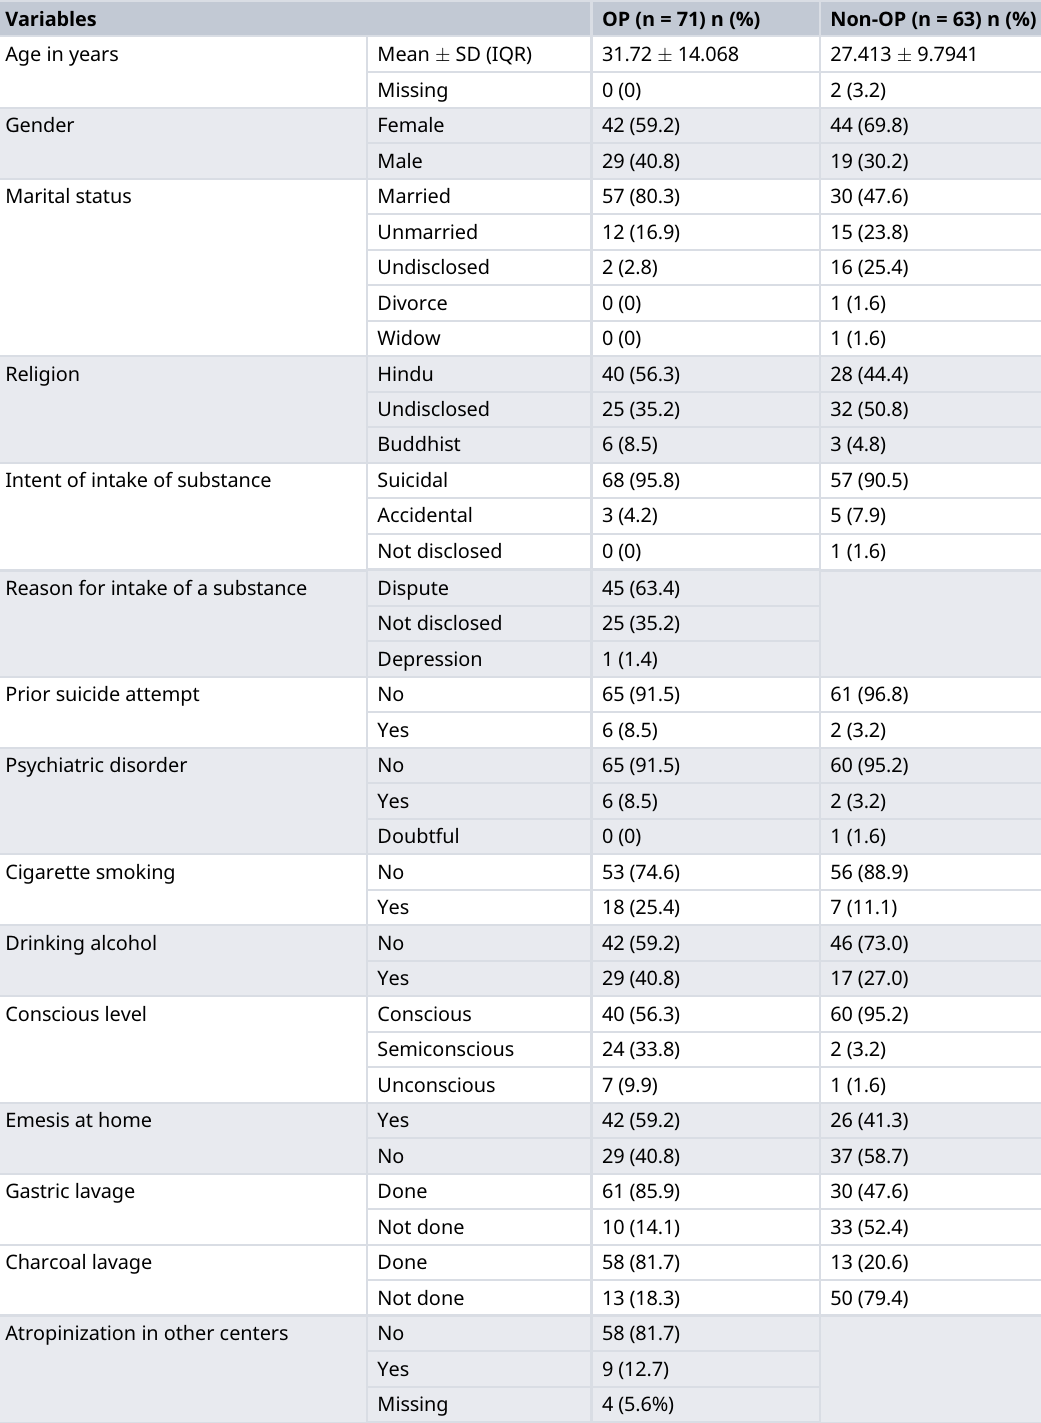
Table 1. Baseline patient details among OP group and Non-OP